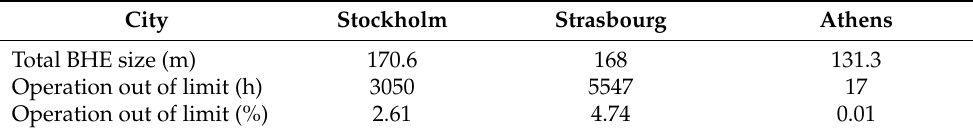
Table 9. Percentage of operation of the DSHP out of the design temperature limits. Preliminary design. City Stockholm Strasbourg Athens Total BHE size (m) 170.6 168 131.3 Operation out of limit (h) 3050 5547 17 Operation out of limit (%) 2.61 4.74